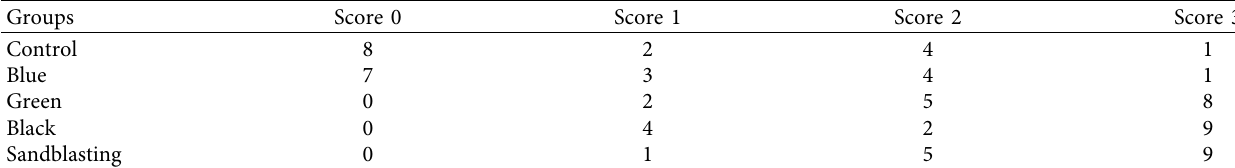
Table 3: Scores for the adhesive remnant index of all groups ( n � 15) according to optical microscope (16x) analysis. Groups